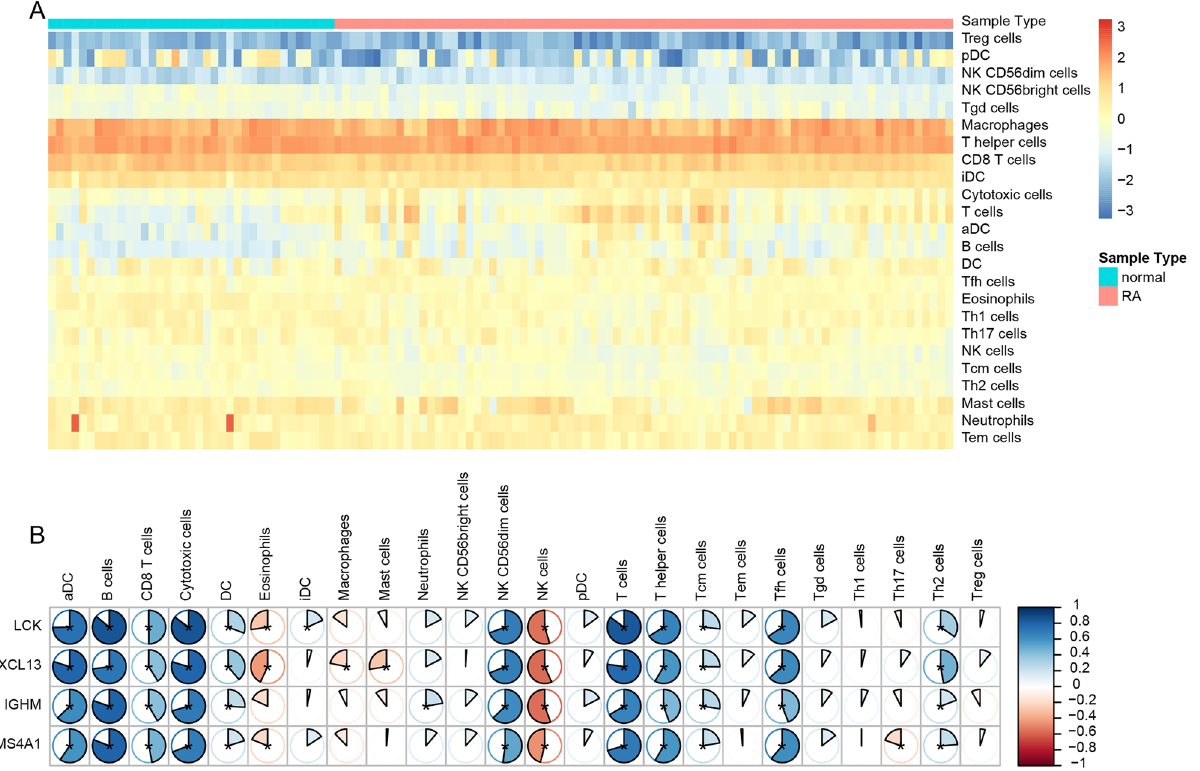
Figure 7. Correlation between the biomarker genes and immune infiltration. ( A ) Heatmap of the infiltration of 24 immune cells between the RA and controls drawn by the “pheatmap” package in R (version 3.6.3) (http:// cran.r- proje ct. org/ bin/ windo ws/ base/ old/3. 6.3/). ( B ) Correlation between the biomarker genes and 24 immune cells